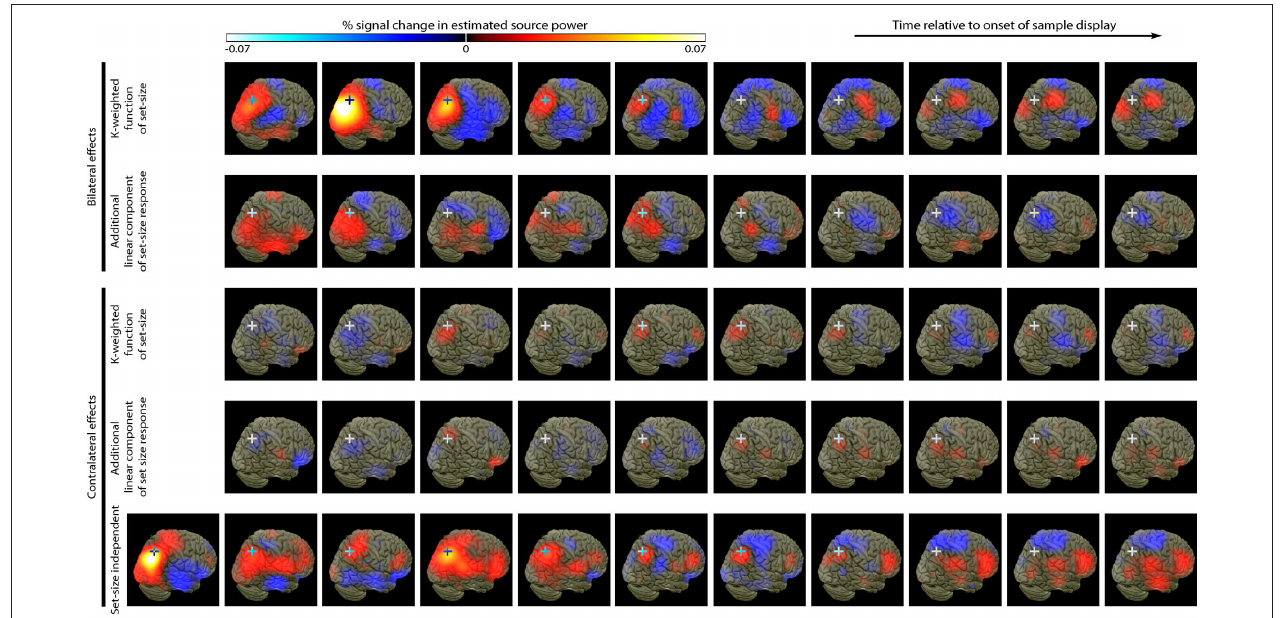
change in power (see Materials and Methods), where this is significantly greater in amplitude than during the baseline period (posterior probability > 0.99). Crosshairs are positioned at the focus of the fMRI marker of VSTM load reported by Todd and Marois (2004; Talairach coordinates: x = 23, y = − 59, z =